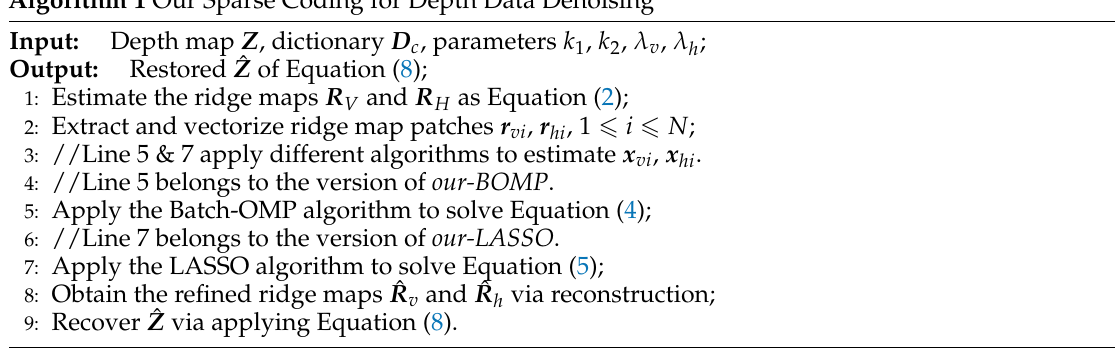
Algorithm 1 Our Sparse Coding for Depth Data